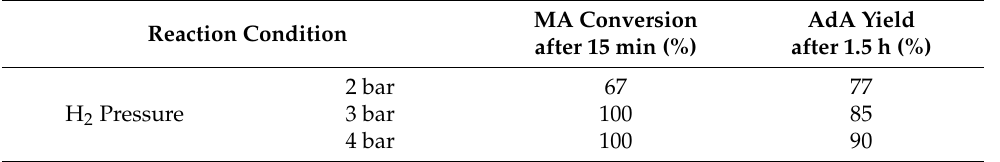
Table 2. Summary of the catalytic results at different H 2 pressures. Reaction conditions: